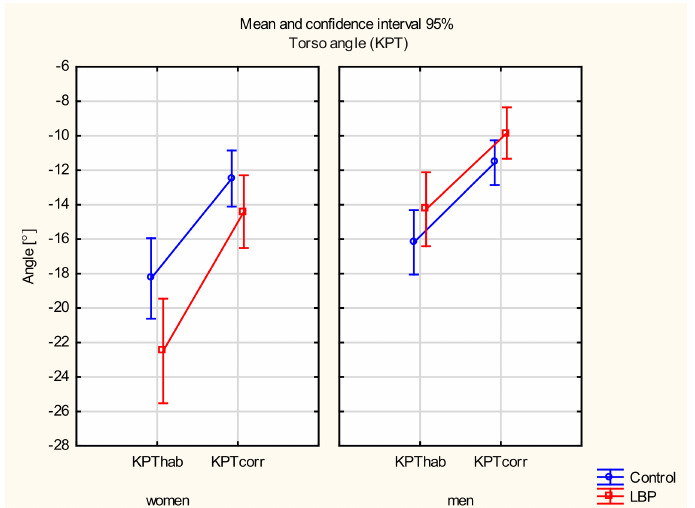
Figure 6. Mean and 95% CI of the torso angle in women and men, in habitual (hab) and corrected (corr) positions, in the control and LBP